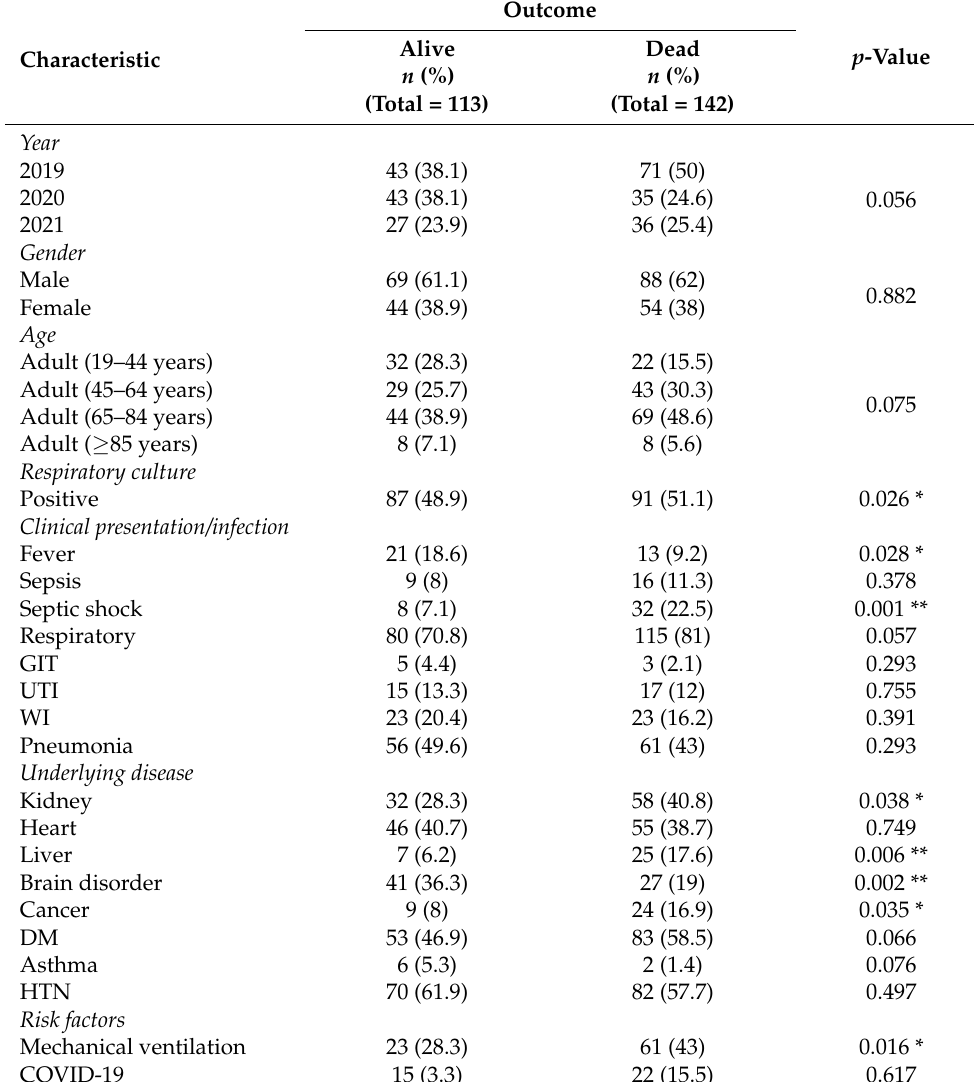
Table 4. Comparison of demographic and clinical characteristics among dead and alive ICU patients infected with multi-resistant P. aeruginosa .